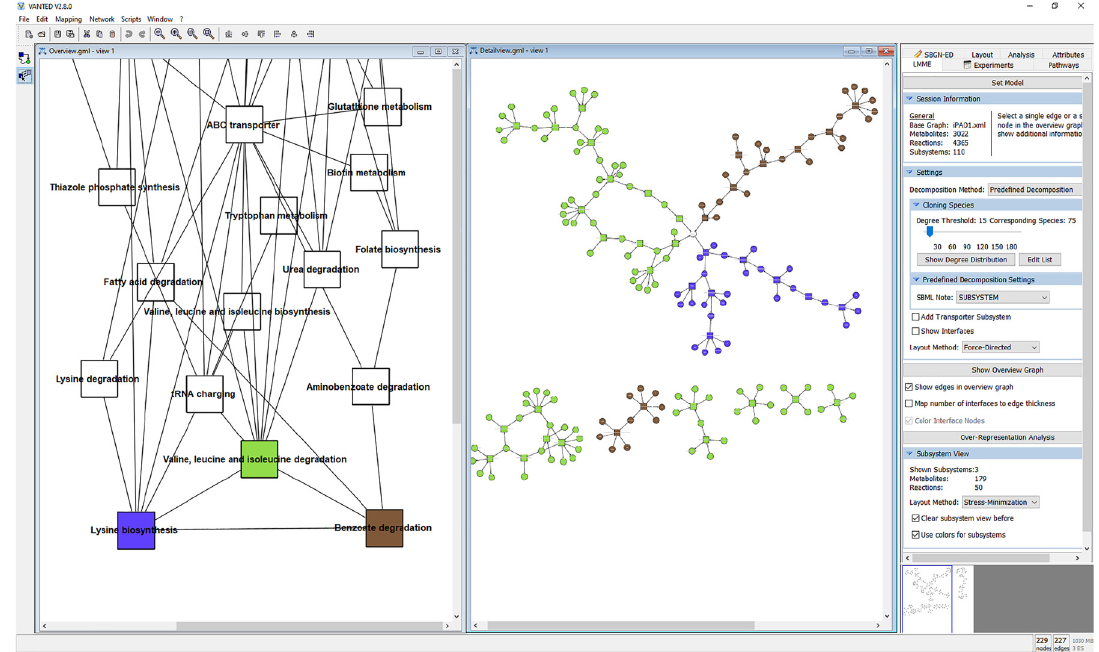
Figure 3: A 2D desktop exploration of iPAO1 , a GSMM for Pseudomonas aeruginosa [79], using LMME. Three pathways have been selected in the overview (left) to be shown in detail (right): Lysine biosynthesis (blue), Valine, leucine and isoleucine degradation (green), and Benzoate degradation